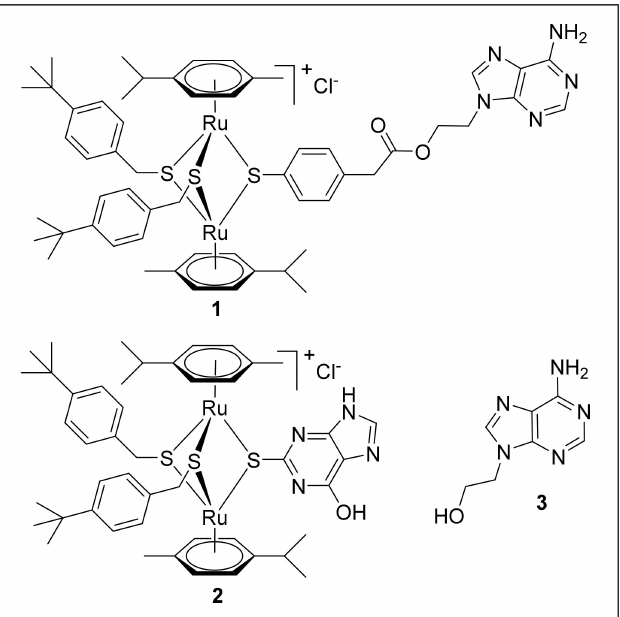
Figure 1. Structure of compounds 1 – 3 used in this study. 1 is a trithiolato–bridged dinuclear Ru(II) –arene conjugate containing a 9–(2–oxyethyl)–adenine unit, 2 is a trithiolato–bridged dinuclear Ru(II)– arene complex with 2–thioxanthine as one of the bridge thiols, and 3 is 9–(2–hydroxyethyl)